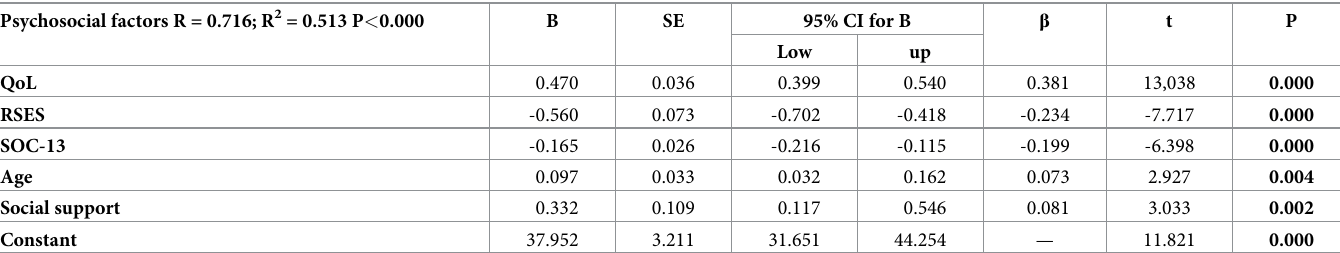
Table 4. Multiple regression analysis with the psychosocial factors as independent variables and the life satisfaction as dependent variables (model 2). Psychosocial factors R = 0.716; R 2 = 0.513 P <